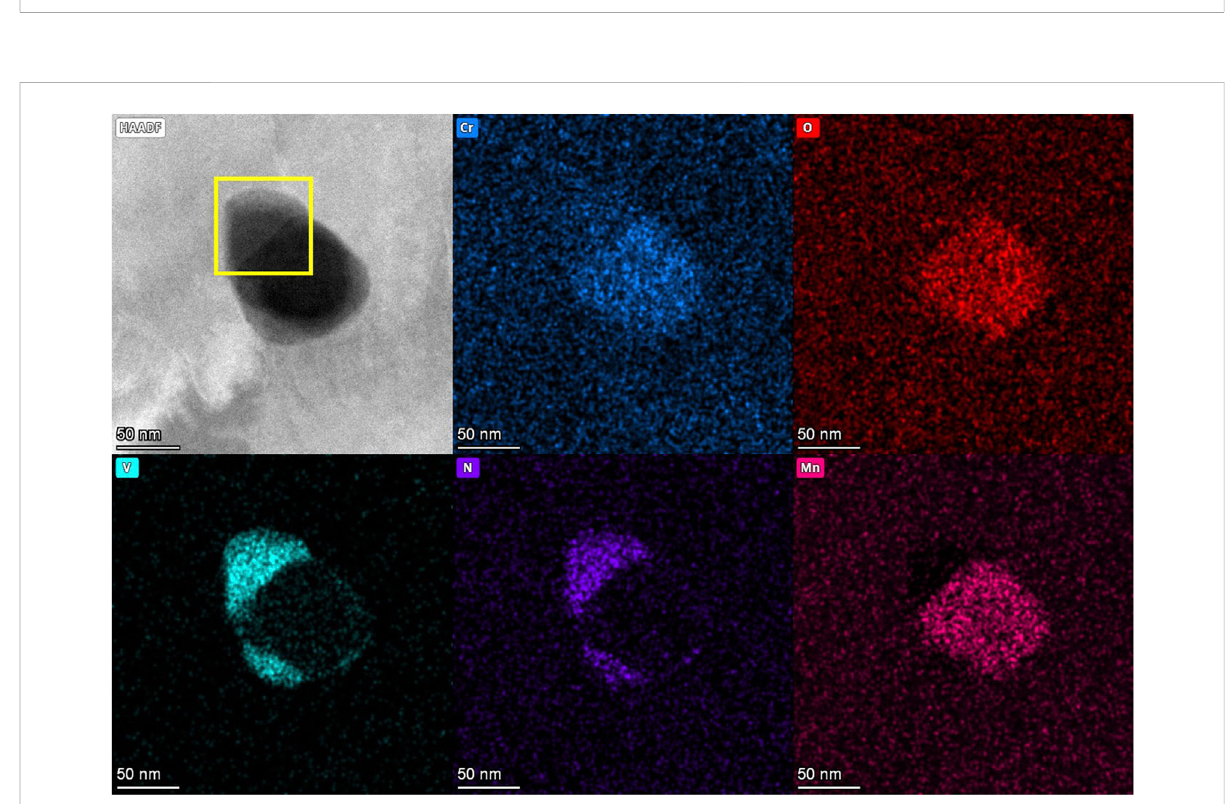
FIGURE 7 HADDF imageandEDS elemental mappingsofVNnearanY-Ta-Sitypeoxide.TheareaofTEMimageinFigure 8isillustratedwith ayellow